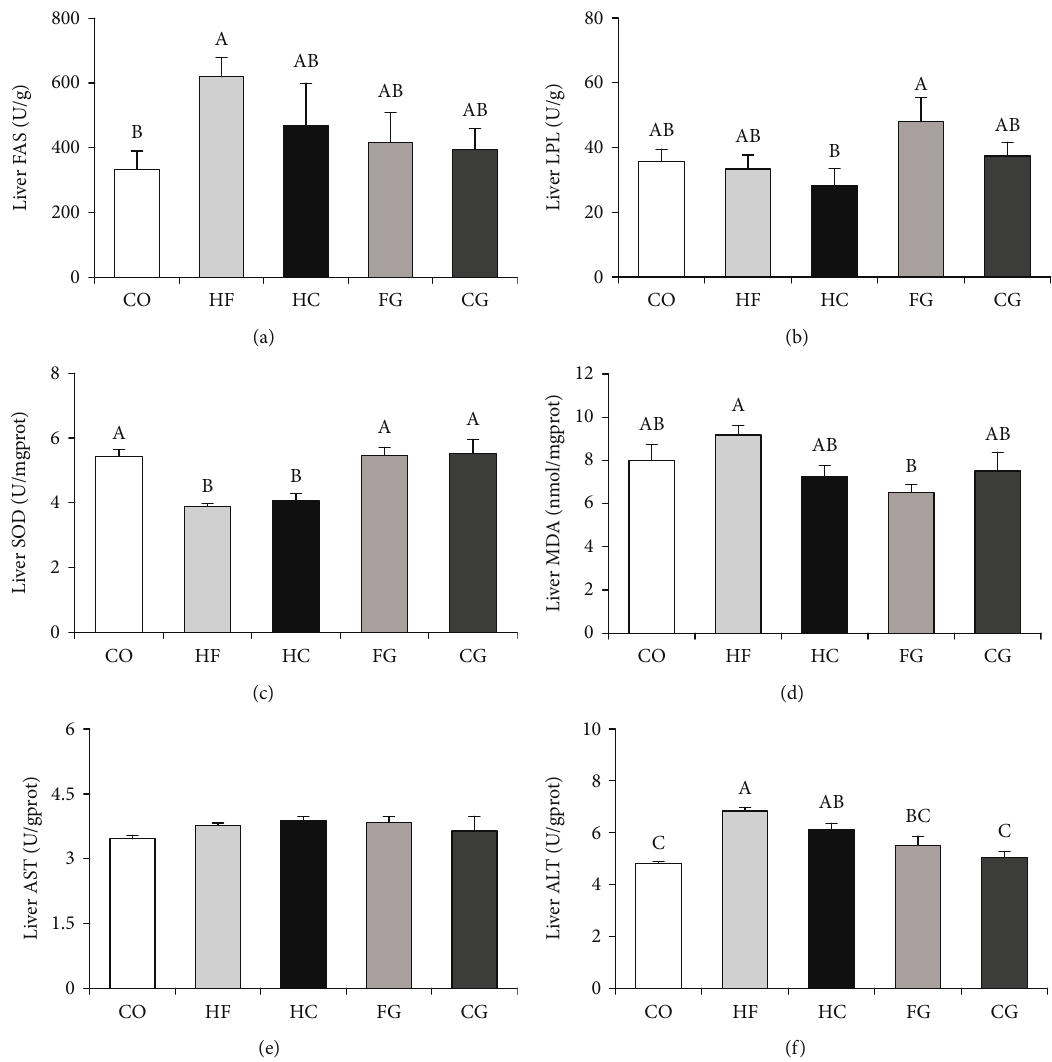
Figure 3: Liver enzyme activity parameters of common carp fed di ff erent experimental diets: (a) fatty acid synthetase (FAS); (b) lipoprotein lipase (LPL); (c) superoxide dismutase (SOD); (d) malondialdehyde (MDA); (e) aspartate aminotransferase (AST); (f) alanine aminotransferase (ALT). Values are means ± S : E : per diet in triplicate tanks ( n = 6 ). The di ff erent letters indicate the di ff erences between diets (one-way ANOVA, Duncan ’ s test, P < 0 : 05 ).